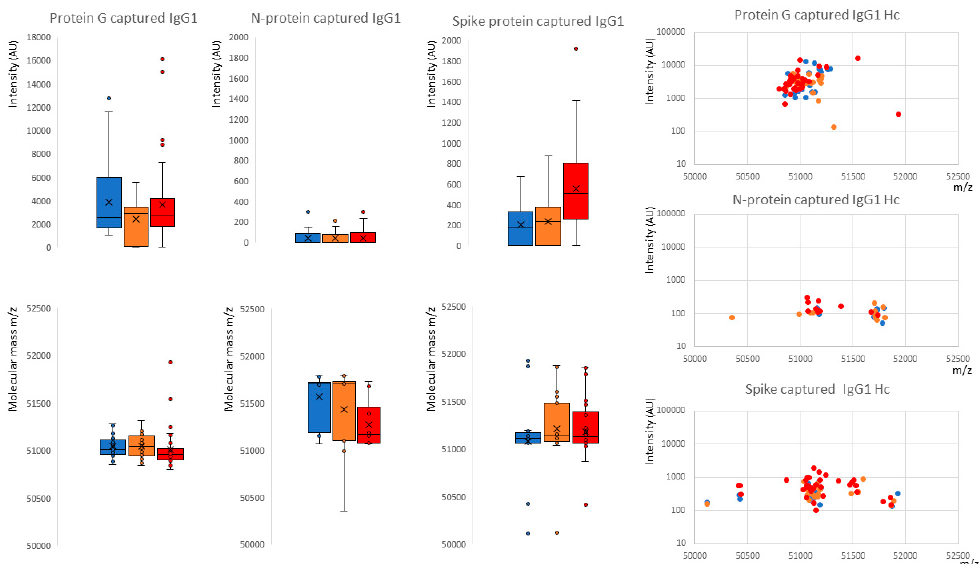
Figure 3. Distribution of intensity for captured and eluted IgG1 heavy chains (IgG1 Hc) and the relative peak molecular mass being bound. The dot plots to the right are intensity versus molecular mass for individual samples; Blue represents data from SARS-CoV-2 sero-negative HCWs, orange from SARS-CoV-2 sero-positive HCWs having recovered from mild symptoms and red sample data from convalescent patients recovering from COVID-19 ARDS. The non-parametric Kruskal − Wallis statistical test was carried out to test differences between study cohorts. The p values (alpha: 0.05) were as follows: protein G capture intensity p = 0.66, molecular weight p = 0.038; protein N capture intensity p = 0.84, molecular weight p = 0.15; protein S capture intensity p = 0.0003, molecular weight p = 0.63.